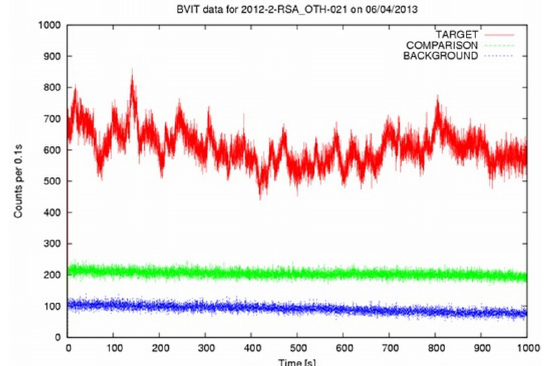
Figure 7: A SALT observations of EX Hya using BVIT which revealed a ∼ 100/50 s